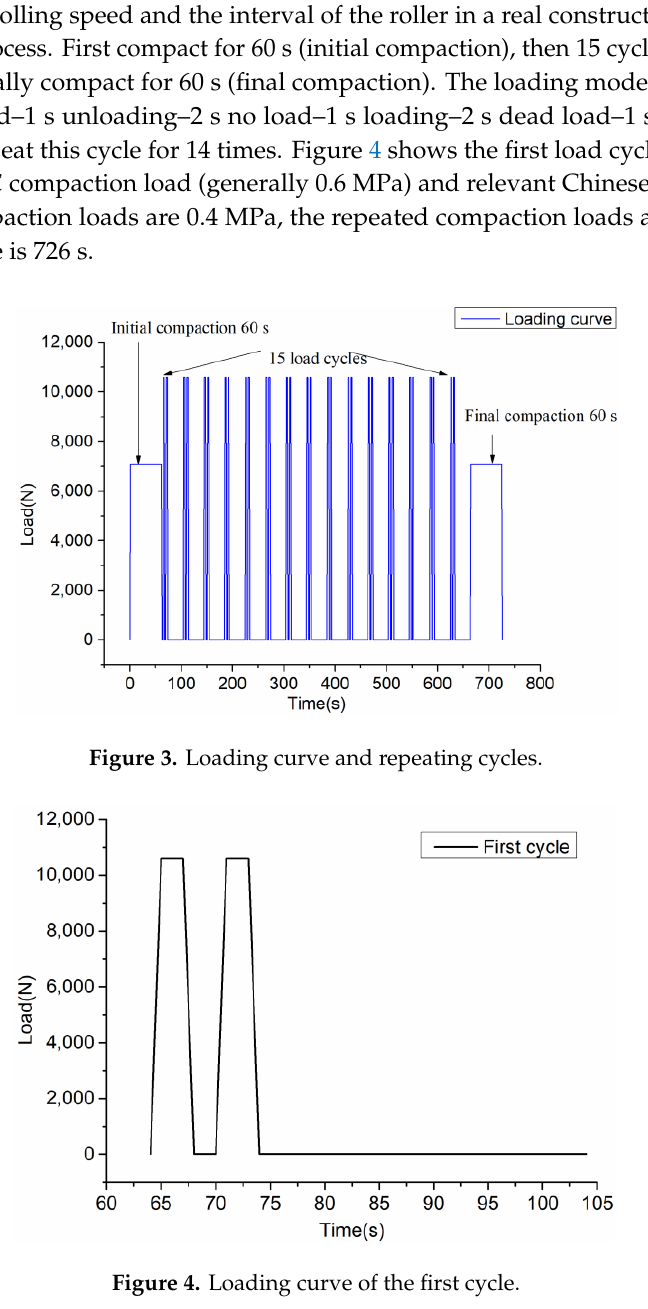
Figure 4. Loading curve of the first cycle.